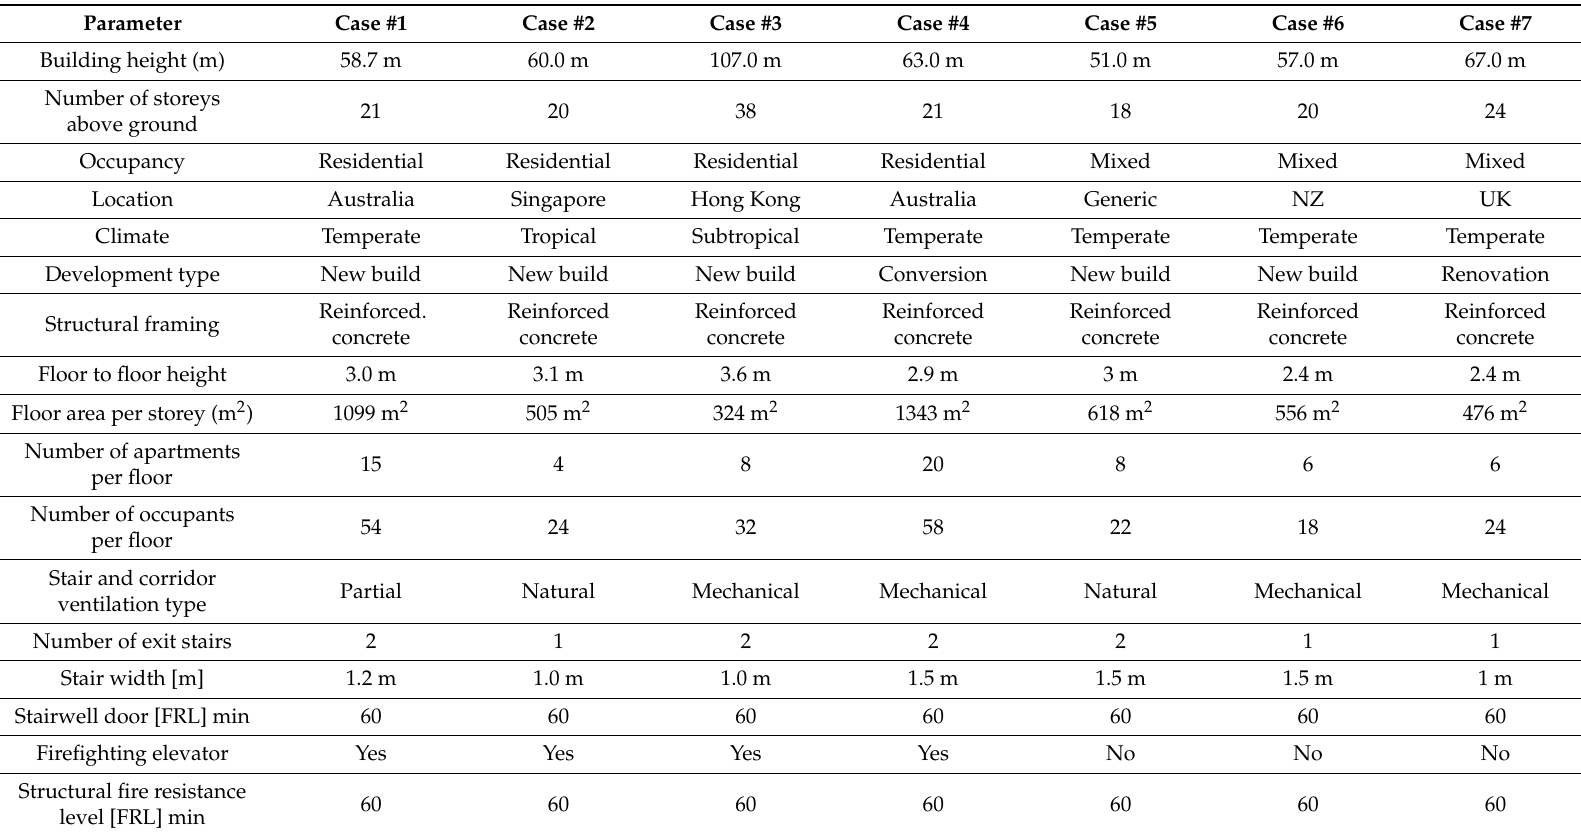
Table 3. General description of case study